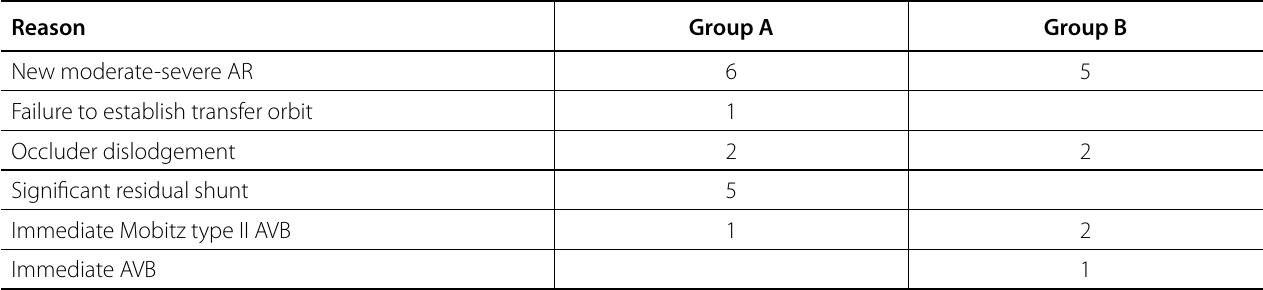
Table 2 . Reasons for conversion to surgery in both groups.